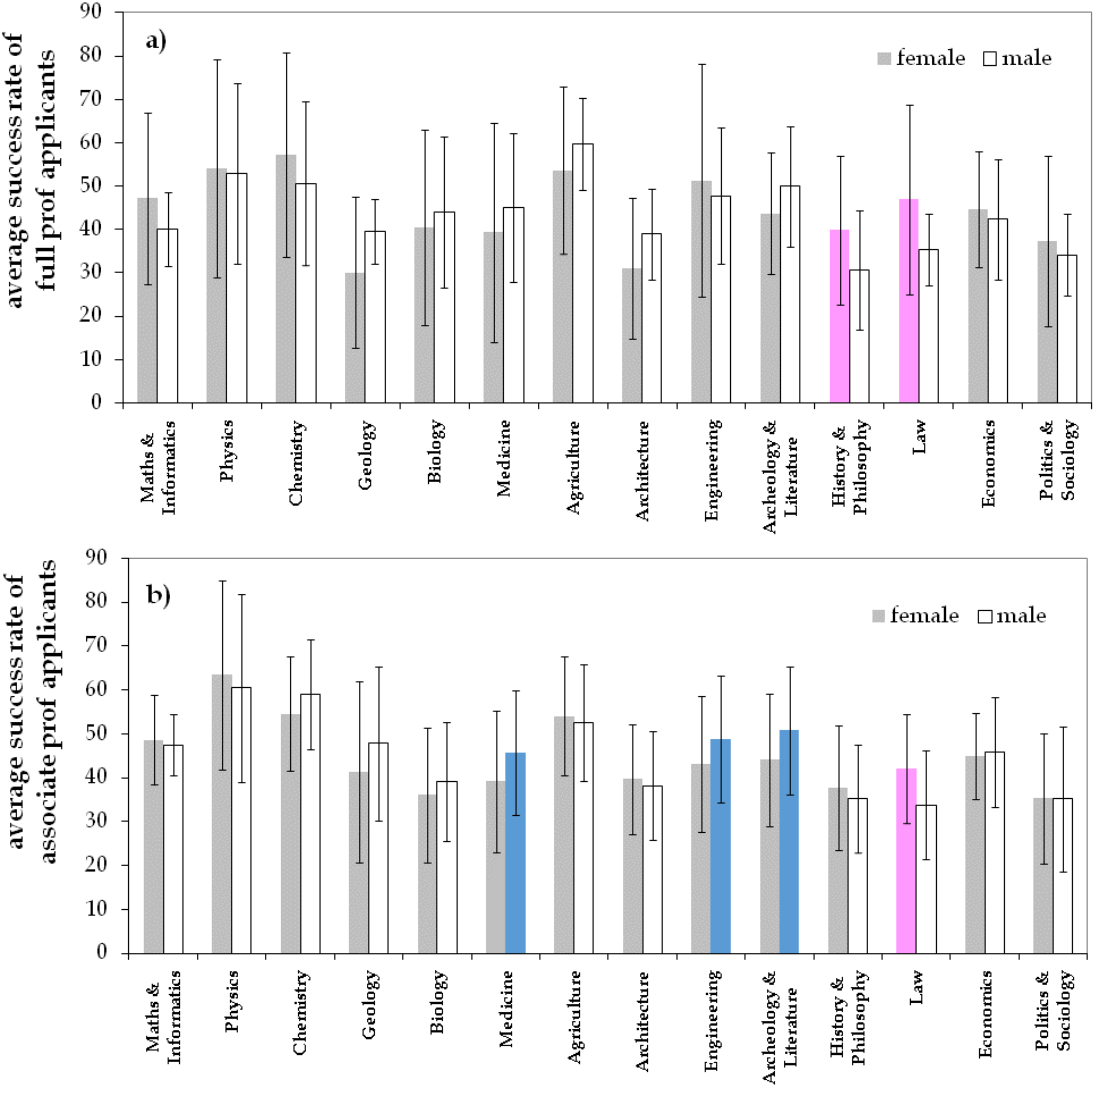
Figure 3. Frequency distribution in the 14 fields of the Italian national habilitation competition (2012) of the average success rates of female vs. male applications for ( a ) full and ( b ) associate professors. Non-significant differences (paired t -test, all with p > 0.05) are shown in grey. The only significant differences are for panel (a) in history and philosophy ( p = 0.02) and (marginally) law ( p = 0.051) (in both cases higher success rate for female candidates), and for panel (b) in medicine ( p = 0.002), engineering ( p = 0.03), archeology and literature ( p < 0.001) (higher success rates for male candidates) and law ( p = 0.003) (higher success rate for female candidates). Error bars show standard